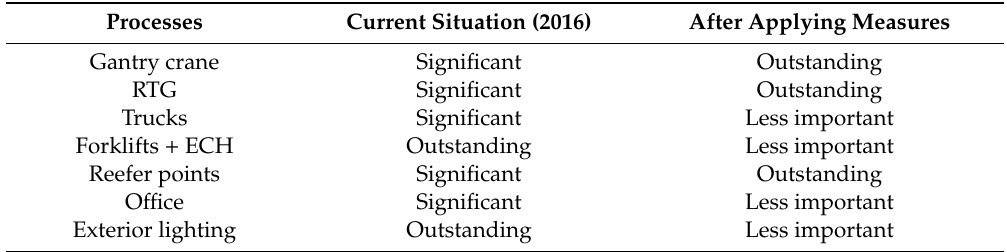
Table 8. RUE Index prediction when applying new measures